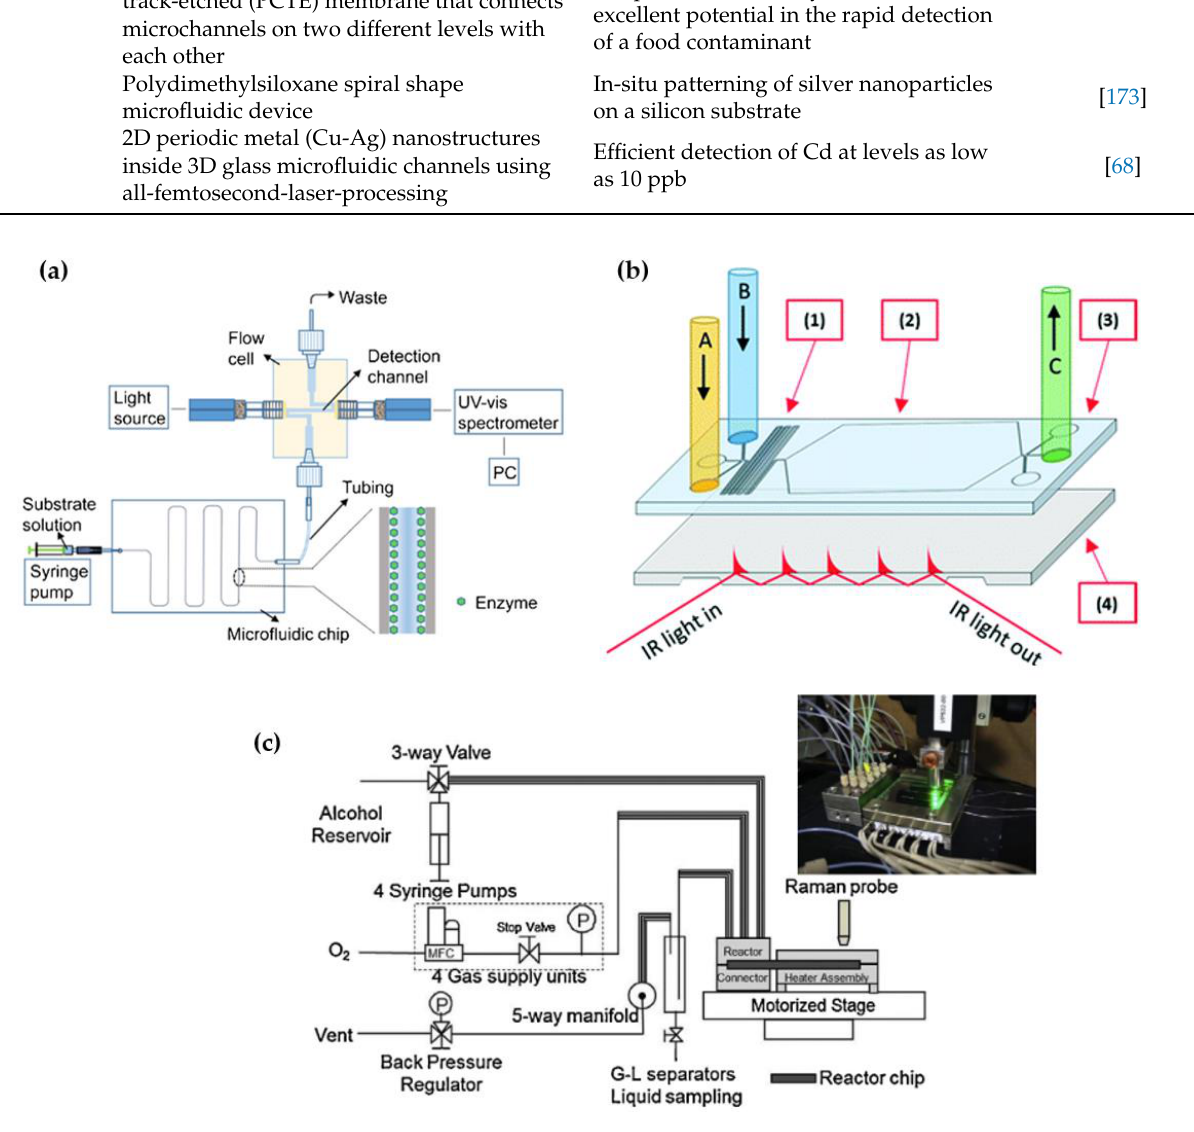
Figure 8. Schematic overview of using microfluidic device coupled with: ( a ) UV-Vis spectroscopy Reprinted with permission from Ref. [174], ( b ) IR spectroscopy Reprinted with permission from the Royal Society of Chemistry from Ref. [19] where following symbols were used (1) mixing channels (2) reaction chamber (3) polymer microfluidic chip (4) silicon internal reflection element and ( c ) Raman spectroscopy Reprinted with permission from Ref. [175] .